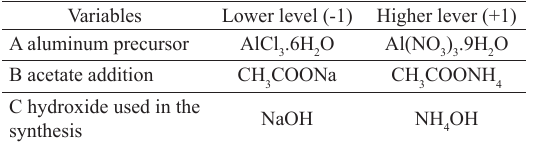
Table 1. Experimental variables and levels. Variables